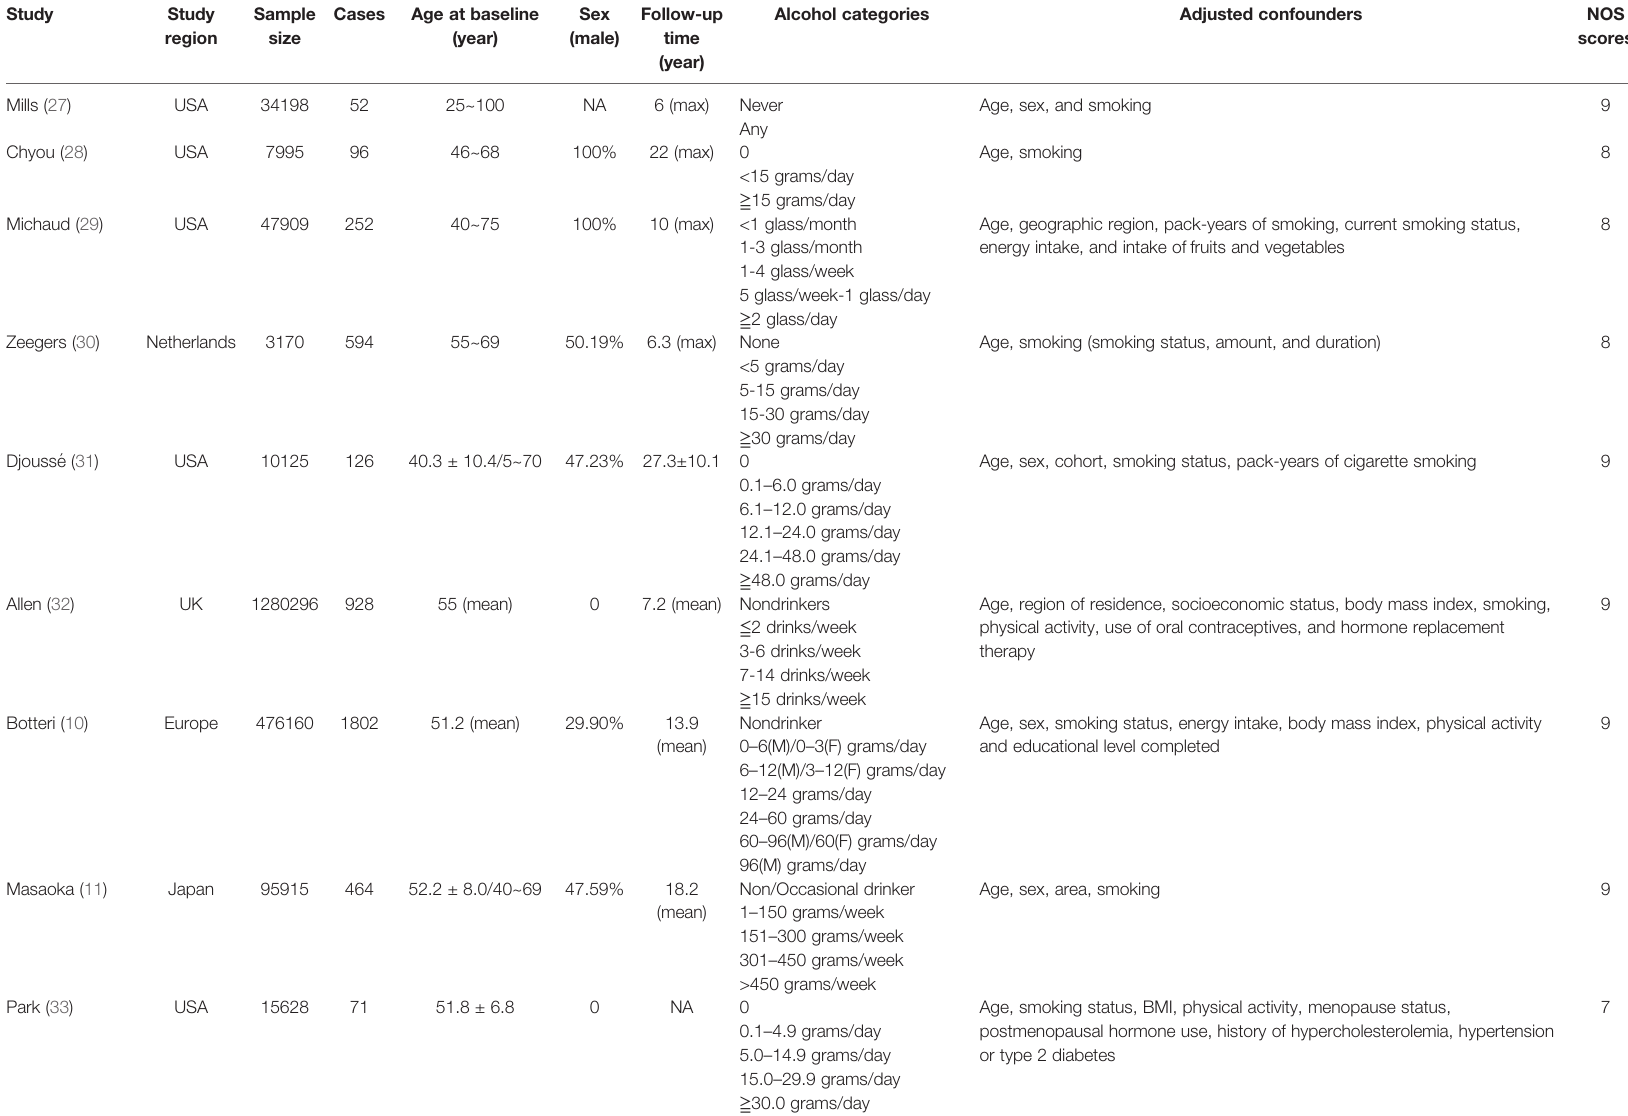
TABLE 1 | Basic characteristic of studies included in the systematic review and dose-response meta-analysis (M: male; F: